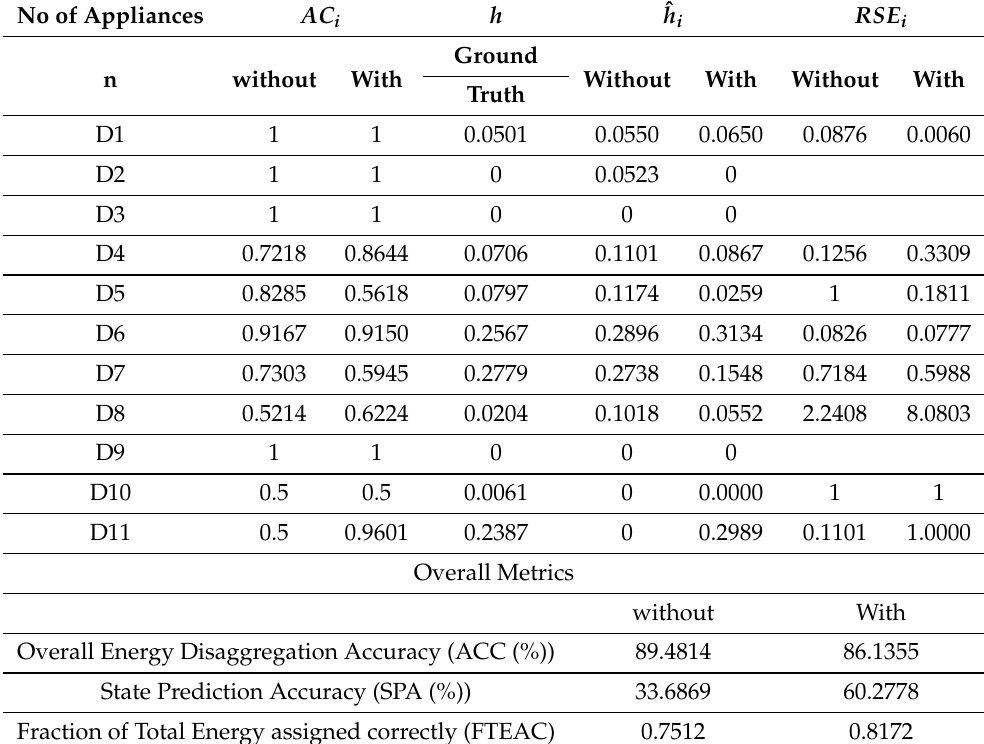
Table 3. Effect of appliance-specific constraints on the performance of energy disaggregation consid- ering the I 12 problem